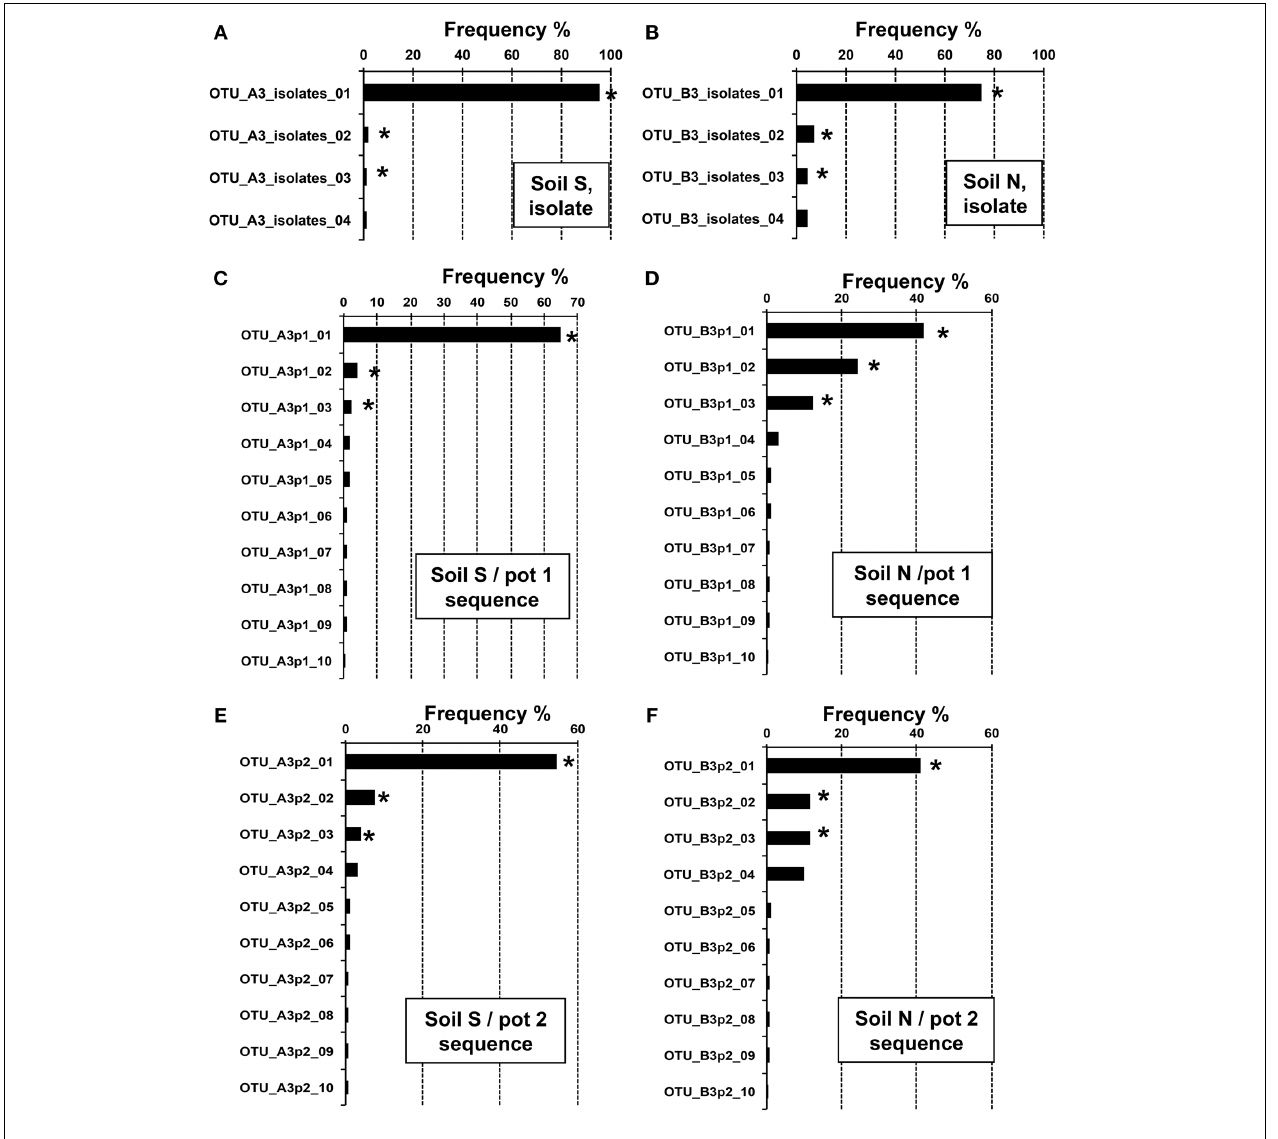
FIGURE 5 | Relative abundance of Burkholderia OTUs in MEP-sprayed soils. Relative abundance of 16S rRNA gene sequences assigned to different OTUs (100% sequence identity thresholds) of the genus Burkholderia in the MEP-degrading isolates (A,B) and the deep sequence